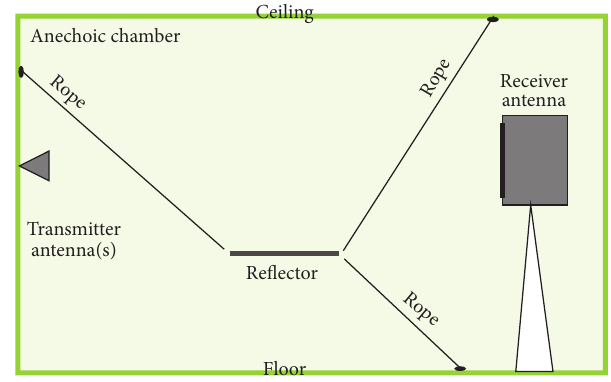
Figure 5: Side view of transmitter and receiver antennas and the reflector in the anechoic chamber. The drawing is not to